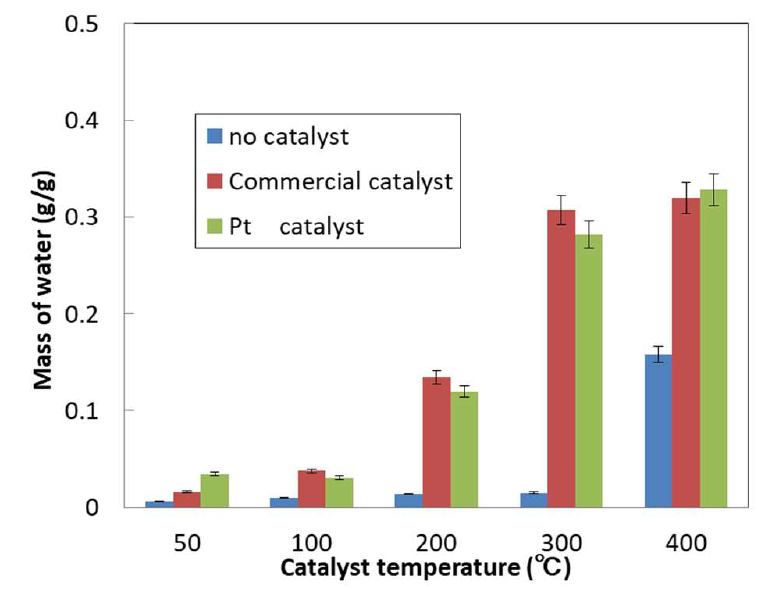
Figure 4. Amount of water produced by the combustion of octane as a function of the catalyst temperature.